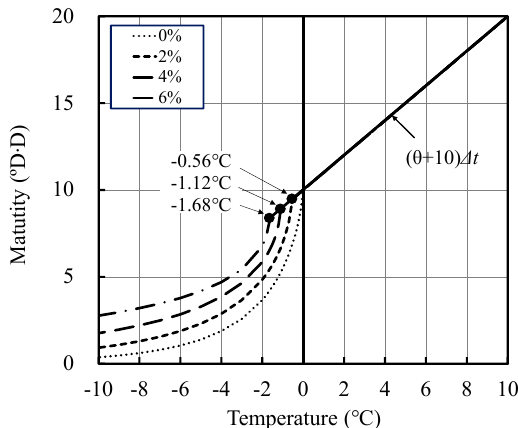
Figure 13. Relationship between the measured compressive strength and calculated compressive